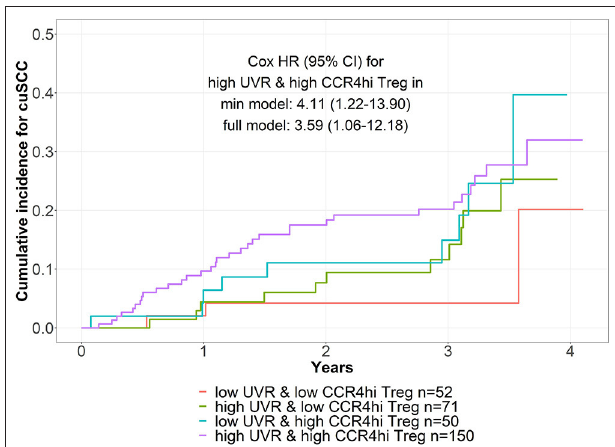
FIGURE 2 | Joint effects of CCR4 hi Treg and spectrophotometer measured UV exposure (UVR) on risk of incident cutaneous squamous cell carcinoma (cuSCC). Cumulative incidence of cuSCC incidence among four groups of cohort participants defined by combinations of higher vs. lower UVR and higher vs. lower CCR4 hi Tregs at baseline. The minimum (min) model was adjusted for age and sex, and the full model was further adjusted for self-reported skin reaction to 1h of sun exposure.